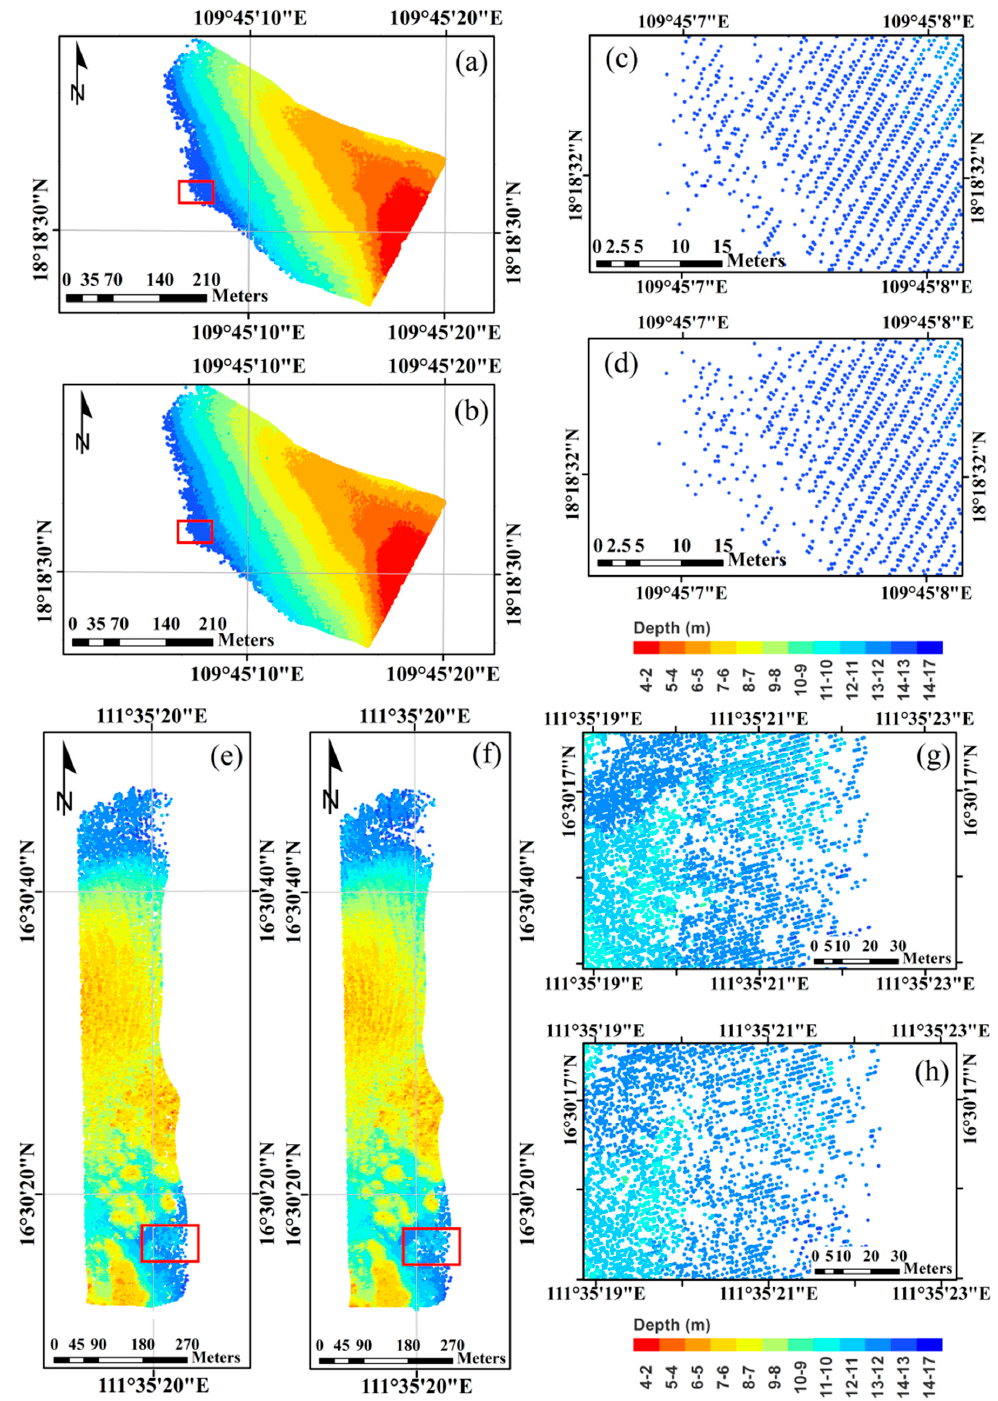
Figure 14. Water depth maps derived using the GHPD method and detailed comparison. ( a , e ) are the water depth maps of the experimental area obtained by IWD; ( b , f ) are the water depth maps of experimental area obtained by GHPD; ( d , h ) shows the details of the areas marked by the red boxes in ( a , d ) obtained using the GHPD; ( c , g ) show the corresponding details obtained using the IWD system.